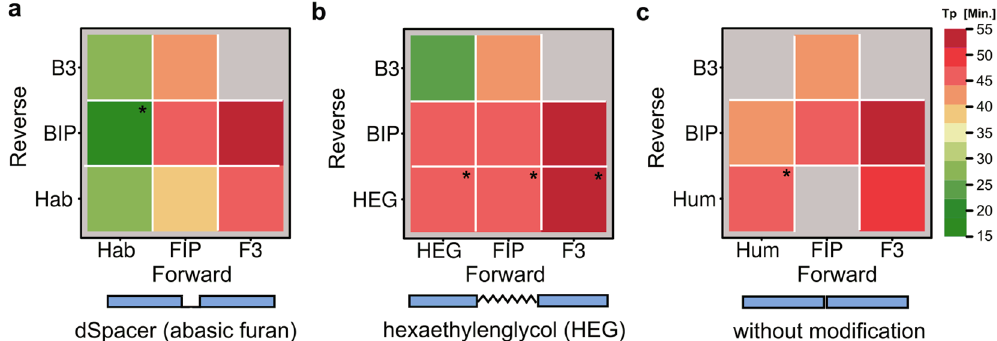
Figure 3. Heatmap representation of the reaction kinetics dependent on primer-modifications. The colors represent different time-to-positivity (Tp) values for each primer combination. ( a ) Hinge-primer reactions with dSpacer (Hab), ( b ) hinge-primer with C12-Spacer (HEG), ( c ) without any modification (Hum). Thus green represents fast and red slow amplification kinetics. B3 and F3 are PCR-like primers used in LAMP, BIP and FIP are loop-forming LAMP primers. The asterix ( * ) represents control reactions without template DNA that showed a detectable amplification signal after 45 minutes. Grey fields show reactions without detectable amplification